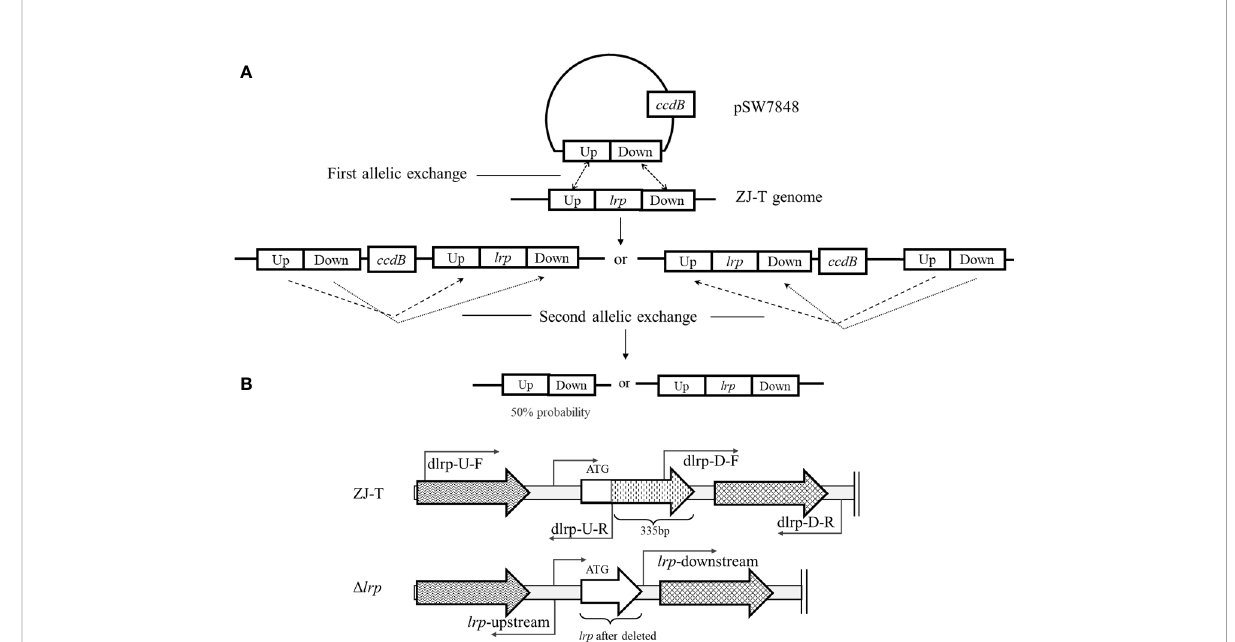
FIGURE 1 The conjugation between recombinant plasmid and V. alginolyticus genome (A) , and the structure of the lrp locus (B) . A: TCBS with 0.2% D-glucose and 20 m g/mL of Cm was used to select transconjugants in the fi rst allelic exchange. TCBS with 0.2% L-arabinose was used to select the transconjugants that underwent plasmid excision in the second allelic exchange. The carried ccdB gene expressed was induced by L- arabinose, then pSW7848 was excised. B: 335 bp of the lrp ORF were deleted from the 33rd codon to the stop codon, giving rise to the D lrp